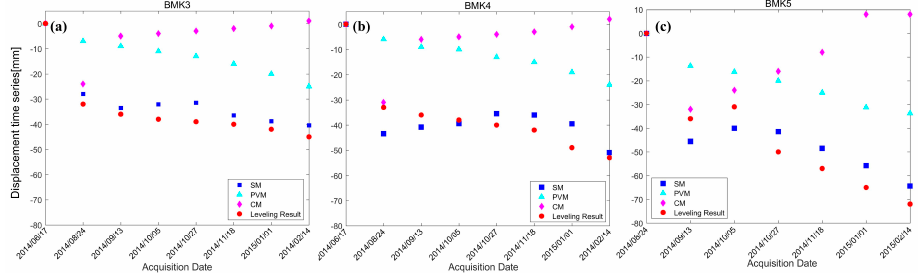
Figure 24. Time series deformation results obtained by 3 models comparison with leveling measurements on: ( a ) BMK3 in Figure 2b; ( b ) BMK4 and ( c )